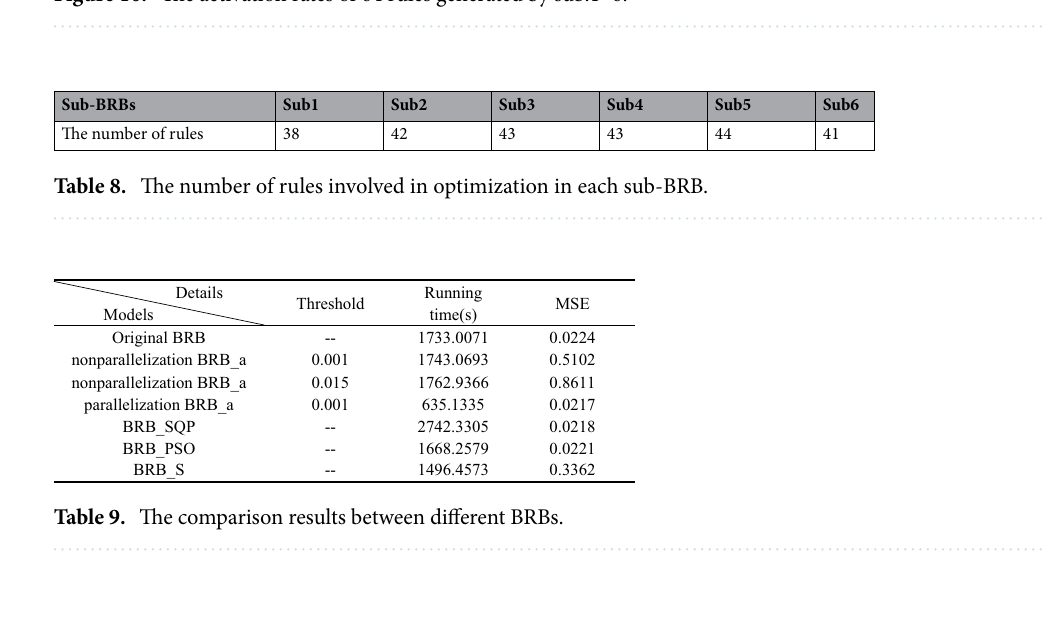
Figure 10. The activation rates of 64 rules generated by sub.1–6.